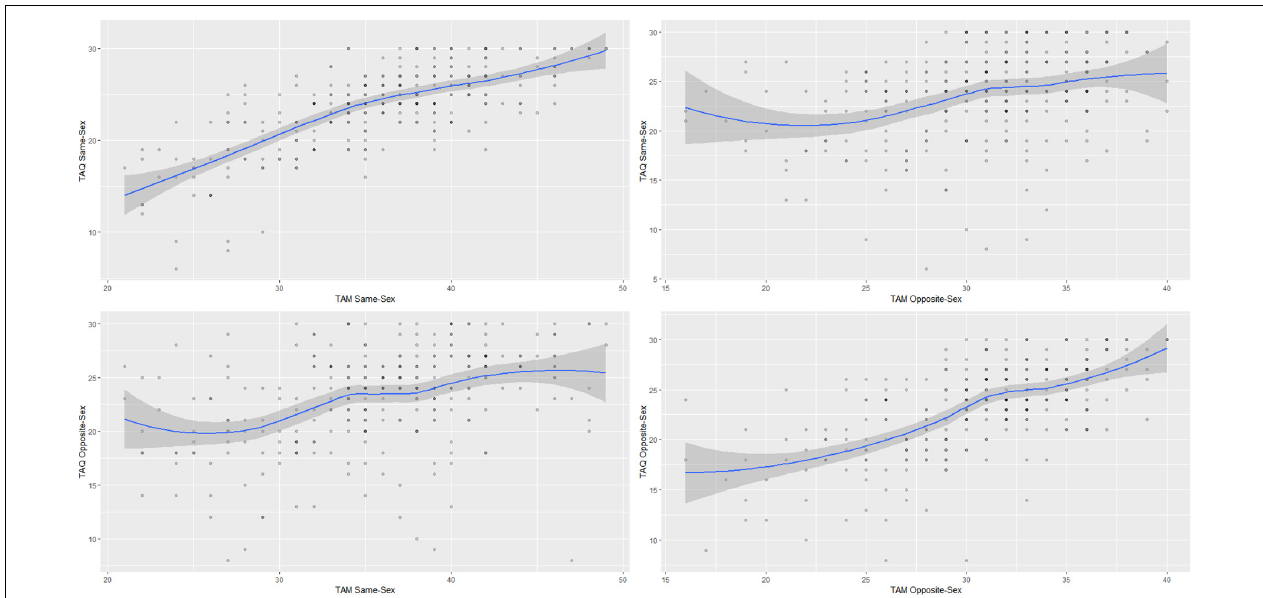
FIGURE 1 | Scatterplots for the Same Sex and Opposite Sex subscales of the Touch Avoidance Measure (TAM) and Touch Avoidance Questionnaire (TAQ). The polynomial regression curve was added to show the approximate linearity of relationship between subscales. The shaded area represents the 95% confidence area for the regression